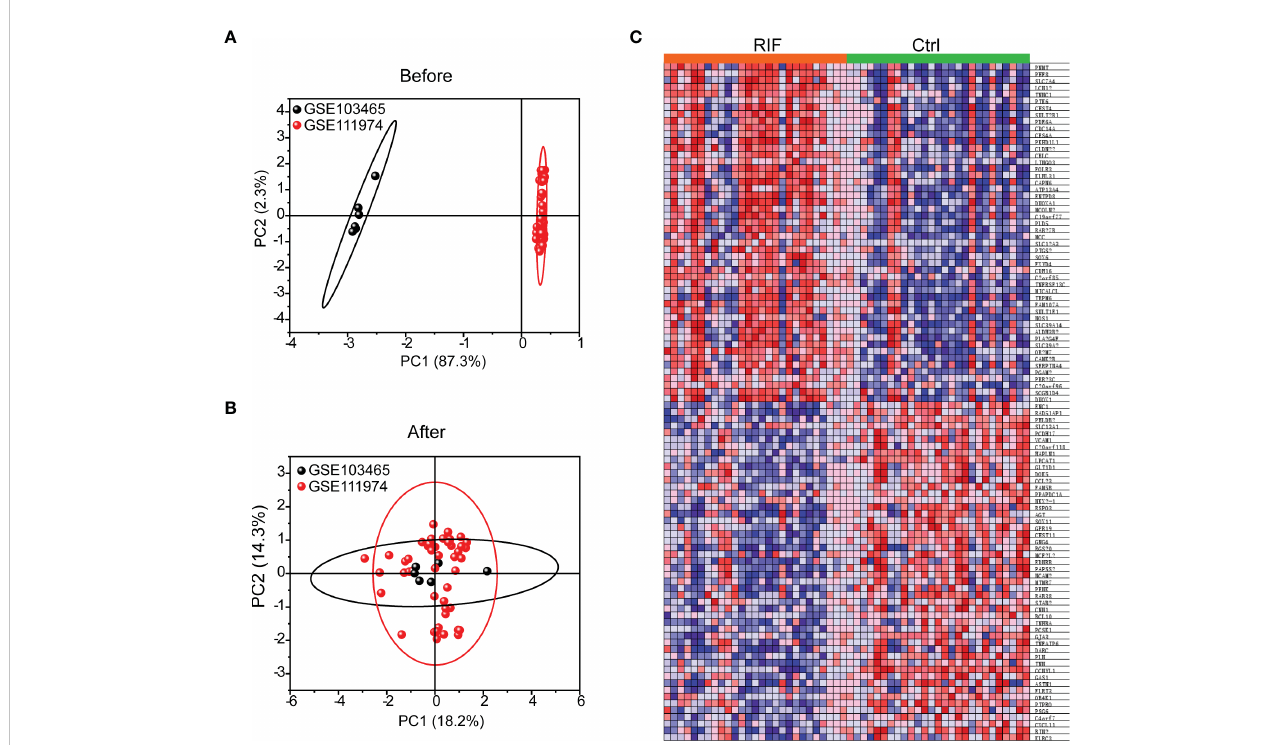
FIGURE 1 Data Preprocessing and Heat map of top 50 genes in RIF and Ctrl groups. (A, B) PCA analysis of GSE103465, and GSE111974 expression pro fi les before (A) and after (B) normalization. (C) Expression of top 50 genes in RIF and Ctrl groups was presented by